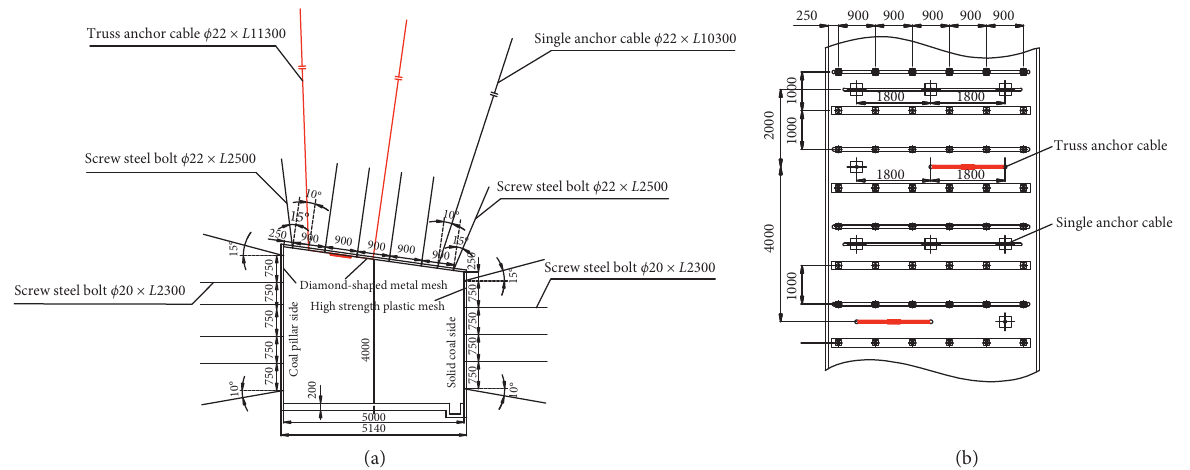
Figure 11: Scheme of rock support system in the roadway. (a) Front view. (b) Top